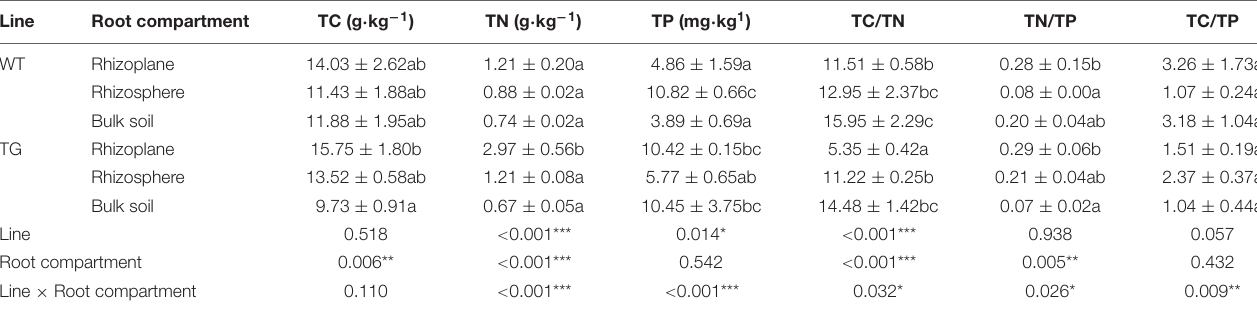
TABLE 1 | Soil chemical properties and the ratio between them according to different compartments.